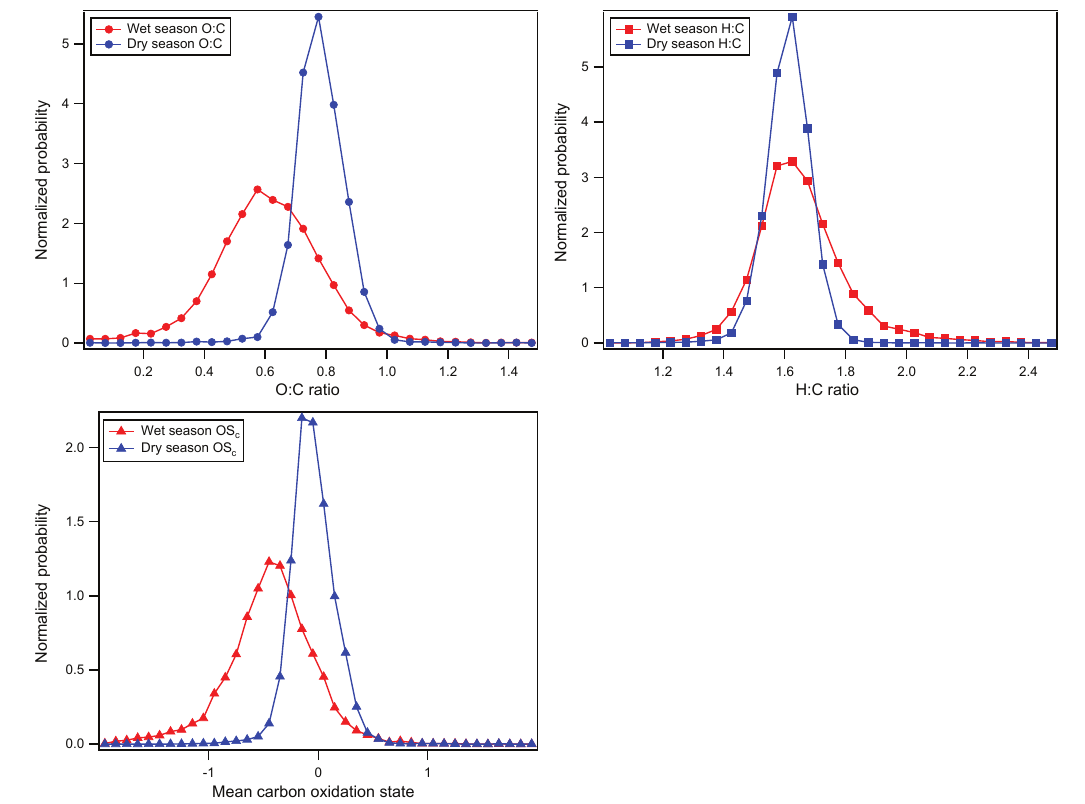
Figure 4. Normalized occurrence probability calculated from G-1 HR-AMS analysis of the organic aerosol during the wet (red) and dry (blue) seasons. O:C and H:C were binned into 0.05-unit-wide bins, and OS c data were binned in 0.1-unit-wide bins. O:C and H:C ratios were calculated using the updated methodology in Canagaratna et al. (2015). Mean carbon oxidation state is calculated according to Kroll et al.